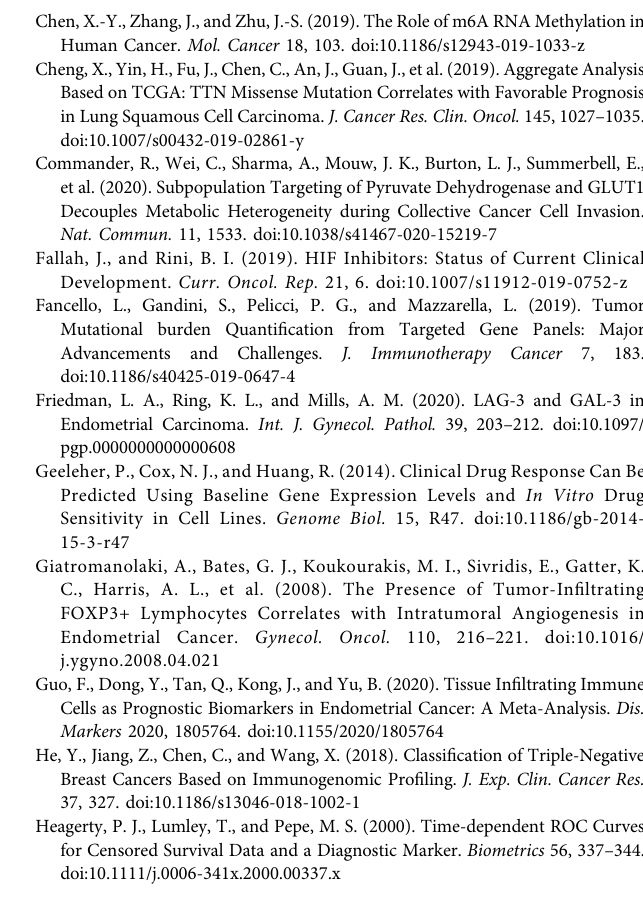
Supplementary Figure S1 | Selected OXPHOS-related DEGs from uterine corpus endometrial carcinoma samples. Heatmap (A) and volcano plot (B) of OXPHOS- related DEGs between UCEC and normal endometrium. Red dots represented up- regulated OXPHOS-related DEGs, green dots represented down-regulated OXPHOS-related DEGs and black dots represented no OXPHOS-related DEGs. Functional annotation of the OXPHOS-related DEGs included Gene ontology analysis (C) and Kyoto Encyclopedia of Genes and Genomes pathway analysis (D) . (E) ThePPInetworkindicatedtheinteractionsbetweenOXPHOS-relatedDEGs. Supplementary Figure S2 | Construction of a prognostic model based on OXPHOS-related DEGs. (A,B) LASSO Cox regression analysis and multivariate Cox regression analysis. (C) Forest plots present the multivariate Cox proportional hazards regression analysis of the prognosis-associated OXPHOS-related DEGs. Supplementary Figure S3 | (A – D) The expression of the four prognostic OXPHOS-related DEGs in tumor ( N (cid:1) 511) and normal tissue ( N (cid:1) 23). (E,F) The relationship between ATP5IF1, FOXP3 and the overall survival of UCEC patients. (G – J) Expression levels of the four OXPHOS-related DEGs mRNA in clinical tissue samples. Supplementary Figure S4 | Strati fi ed analysis. (A – H) The Kaplan-Meier survival analyses based on the prognostic signature strati fi ed by tumor stage, tumor grade, histologicaltype, patient age in the TCGA-UCEC cohort. (I – L) Relationship between the prognostic signature and tumor stage, tumor grade, histological type and age in the TCGA-UCEC cohort. Supplementary Figure S5 | The heatmap shows the OXPHOS-related prognostic genes expression and clinical characteristics of the TCGA-UCEC cohort. Supplementary Figure S6 | Variant classi fi cation, mutation type, SNV class, mutation load and top 10 mutated genes in UCEC between low (A) and high risk groups (B) . In the high risk group, N (cid:1) 267; in the low risk group, N (cid:1)